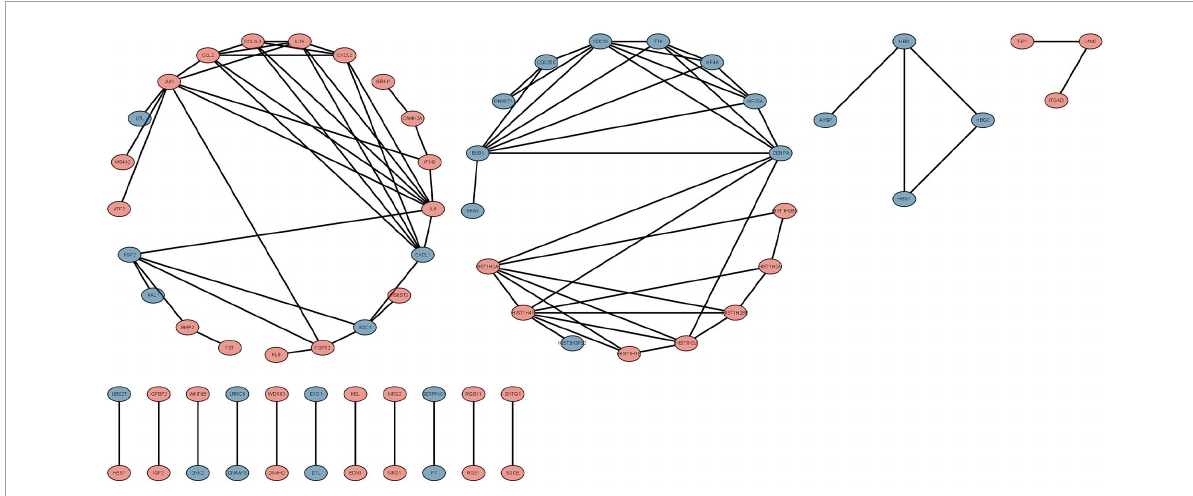
FIGURE5 The protein-protein interaction (PPI) network of differentially expressed genes (DEGs). Circles and lines represent genes and the interaction of proteins between genes, respectively. The red represents the up-regulated genes. The blue represents the down-regulated genes.